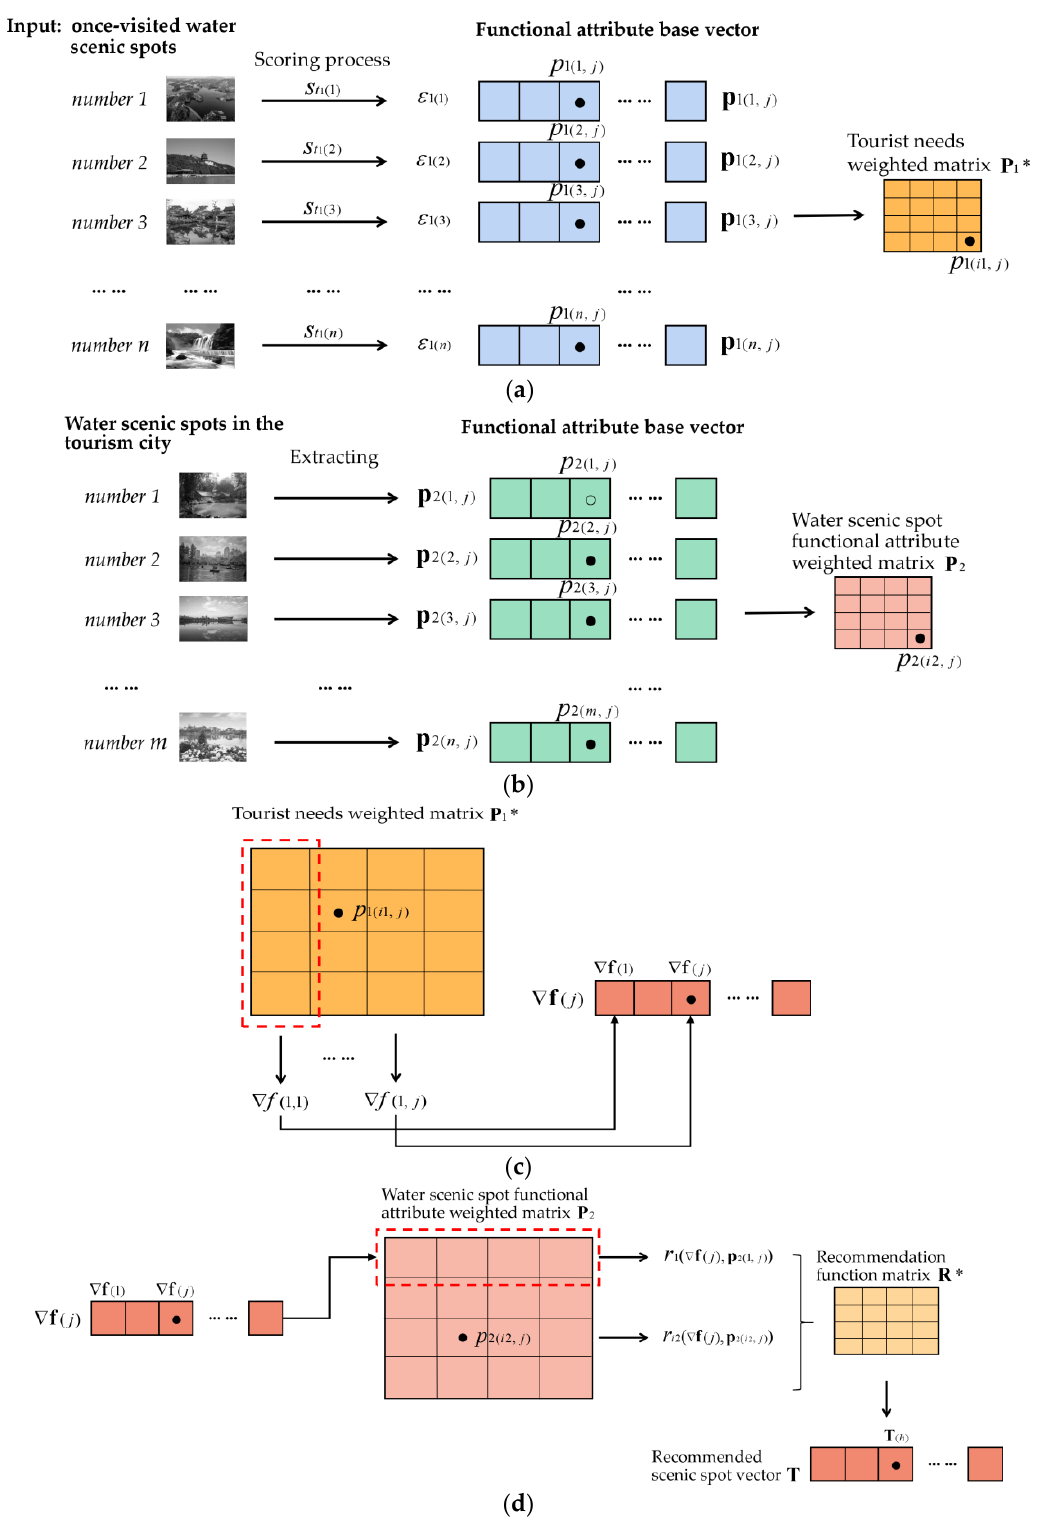
Figure 1. The process of water scenic spot recommendation. ( a ) shows the process to output the tourist-needs matrix. ( b ) shows the process to output the water scenic spot functional attribute- weighted matrix. ( c ) shows the process to output the tourist-needs relative weight vector and ( d ) shows the process to finally output the water scenic spot recommendation vector.